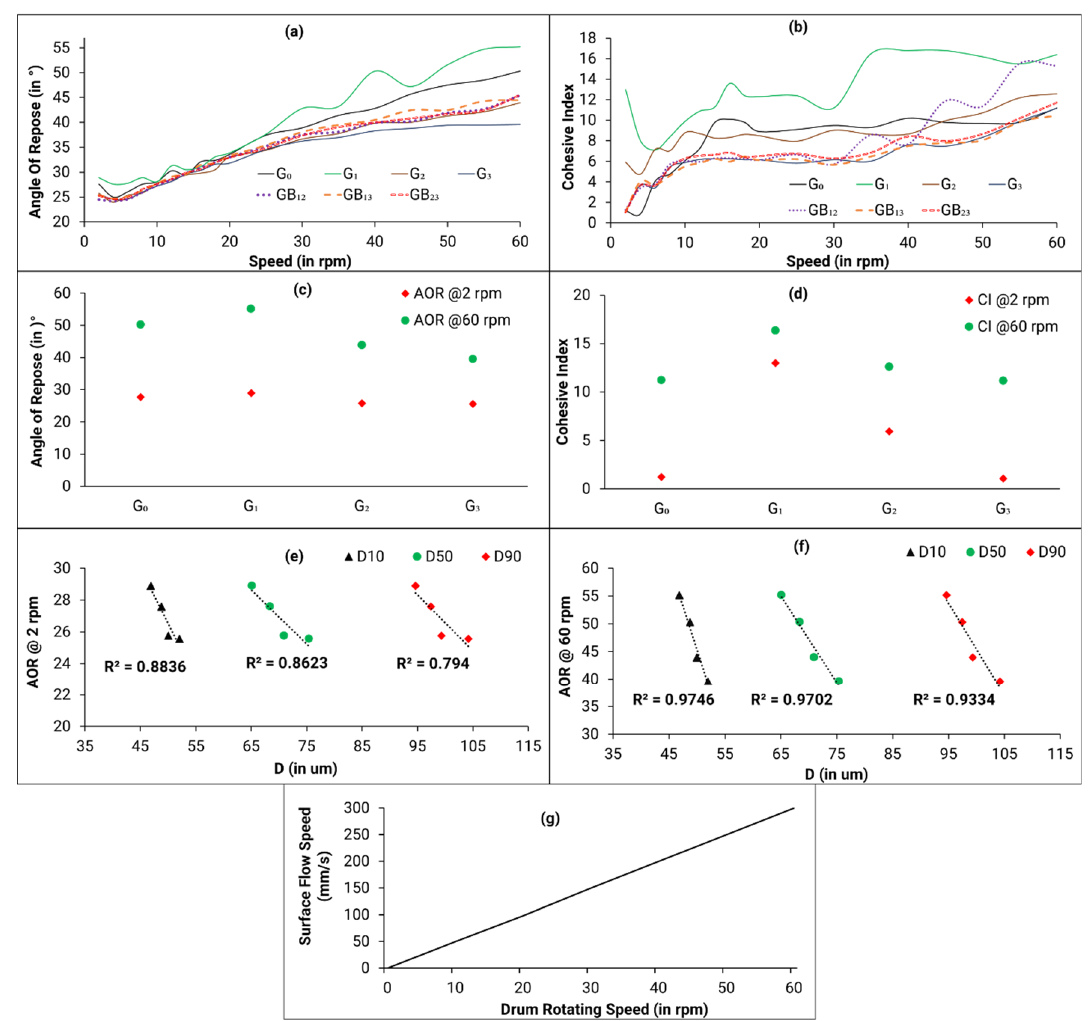
Figure 6. ( a ) AOR vs. speed of drum rotation for all powder types; ( b ) CI vs. speed of drum rotation for all powder types; ( c ) AOR at 2 and 60 rpm vs. number of reuse cycles; ( d ) CI at 2 and 60 rpm vs. number of reuse cycles; ( e ) AOR at 2 rpm vs. particle size (D values) for individual genesis powder types; ( f ) AOR at 60 rpm vs. particle size (D values) for individual genesis powder types; ( g ) relationship between drum rotating speed and surface flow speed (Redrawn from [34]). Note than G 0 powder is considered an anomaly due to the fact that it has not undergone any processing, blasting, or sieving procedure.